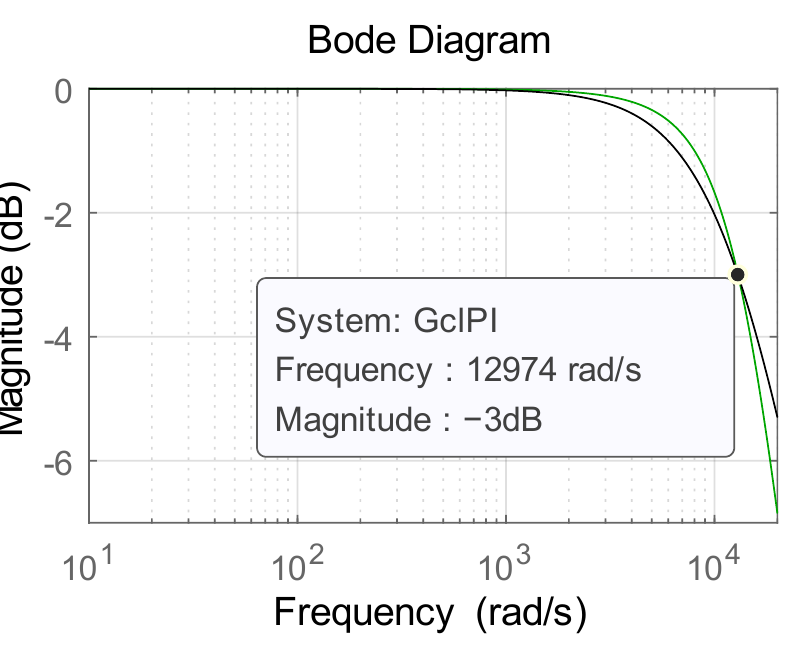
Figure 7. Bode diagram of closed-loop transfer functions (Green line, complex vector controller; Black